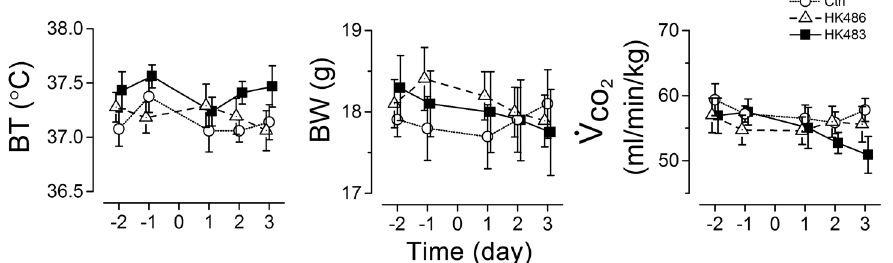
Fig 1. Effects of H5N1 viral infection on animal body temperature (BT), body weight (BW), and (cid:1) metabolism ( V CO 2 ). In each mouse of the three groups (n = 6, 15, and 7 for Ctrl, HK483 and HK486 mice), the (cid:1) same measures (BT, BW, V ) were repeated at 2 and 1 days before and 1, 2, and 3 days after intranasal CO 2 inoculation (Day -2, -1, 1, 2, and 3). Mean ± SE. As the results show, there is no signi fi cant difference of BT, (cid:1) BW and V among the three CO 2